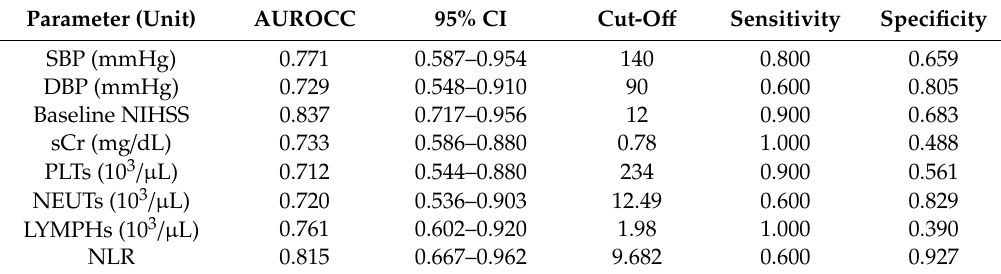
Table 3. Details of the receiver operating characteristics (ROCs)